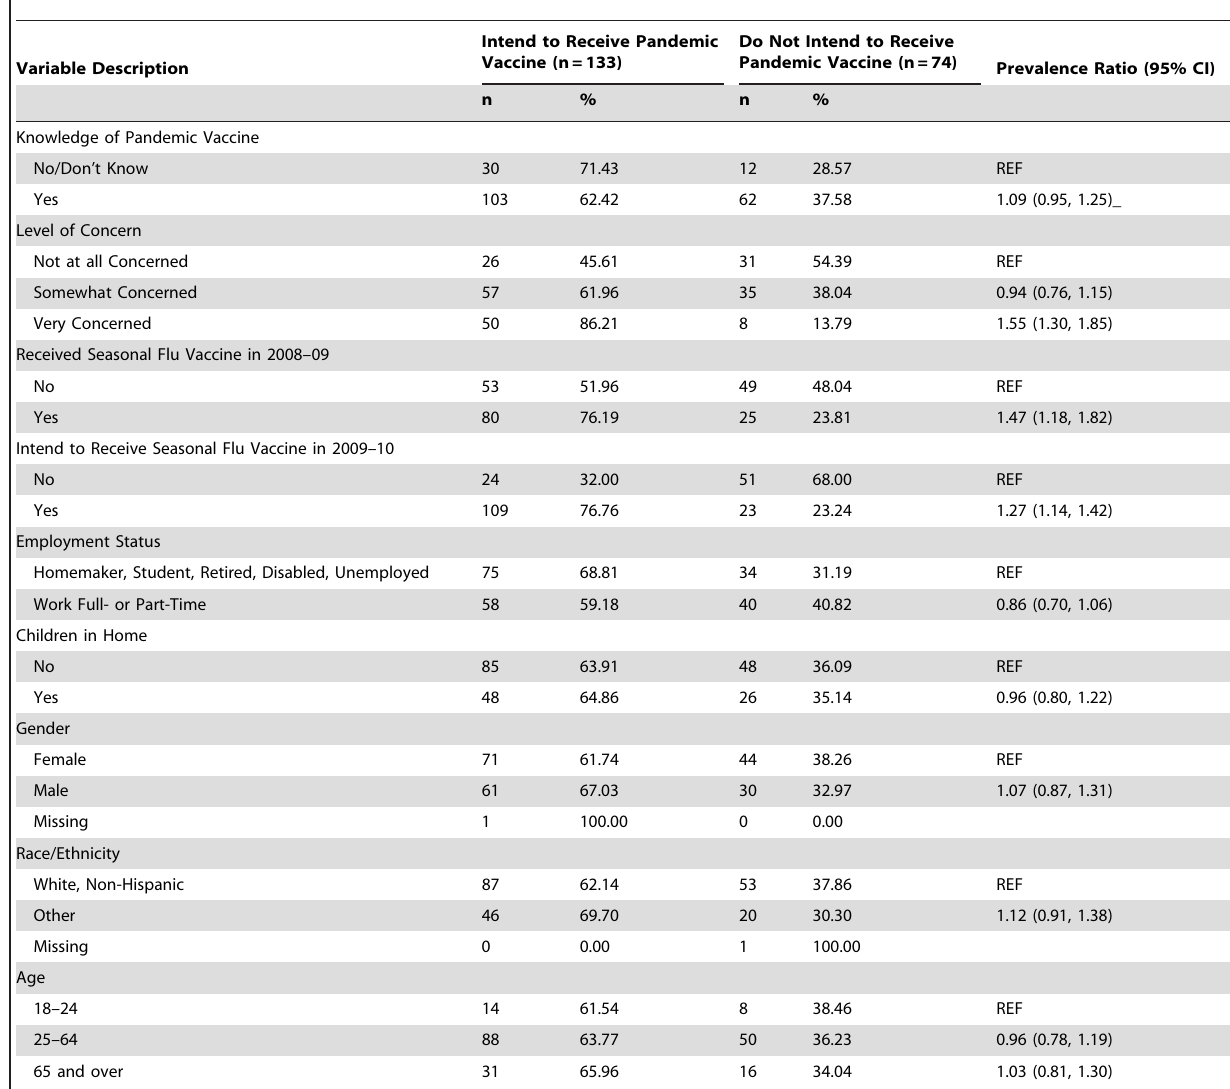
Table 1. Factors potentially associated with intent to receive pandemic H1N1 vaccination, North Carolina, 2009 (N =207).